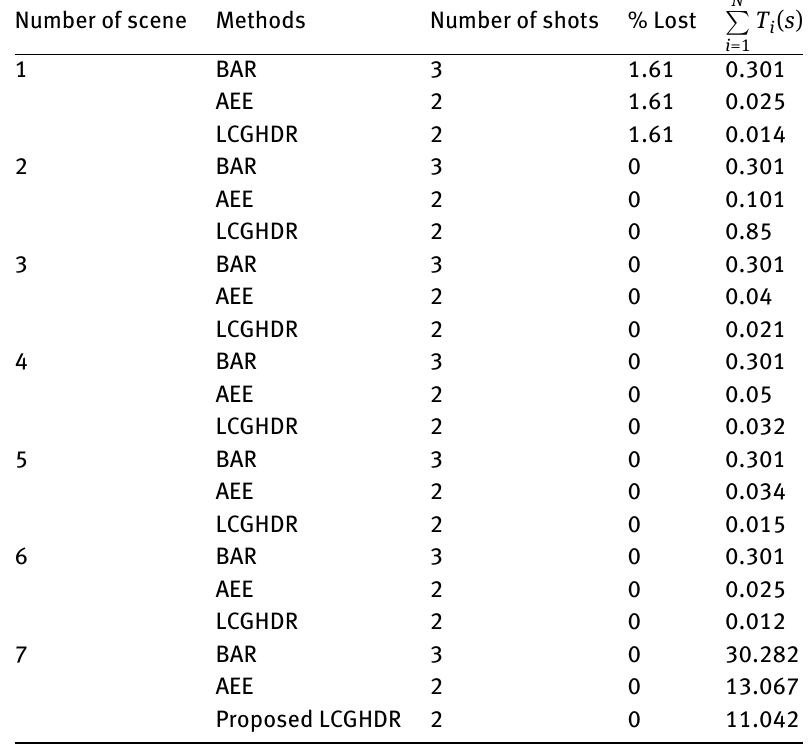
Table 2: Comparison of BAR, AEE and LCGHDR